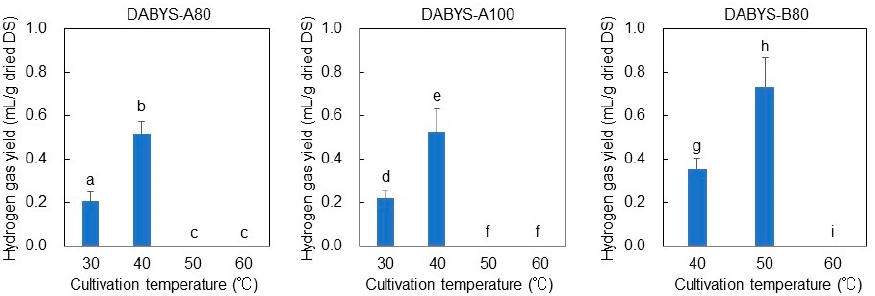
Figure 5. Influence of temperature on the hydrogenic activity of DABYS-A80, -A100, and -B80 in the dark fermentation. The data are presented as the mean ± standard deviation of independent triplicates. The letters above the columns indicate significant differences at p < 0.05 (Student’s t -test).